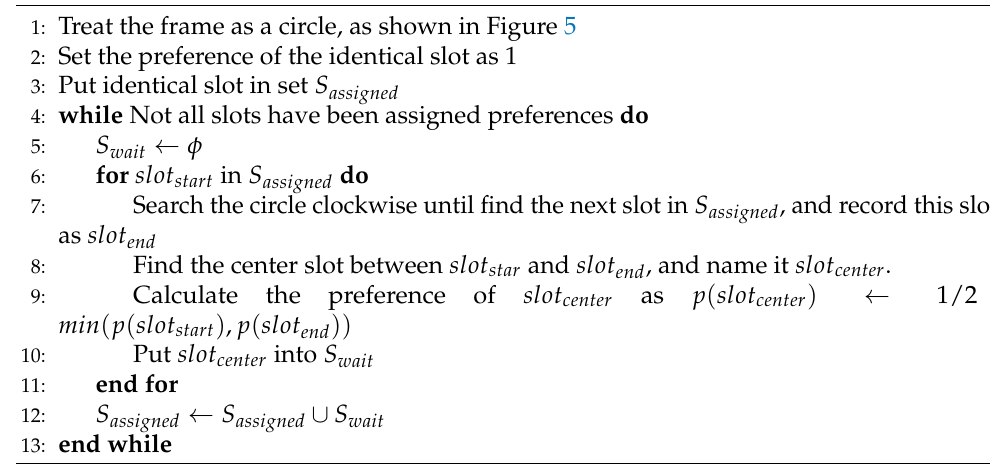
Figure 5. Calculation of preference. Algorithm 2 Calculation of